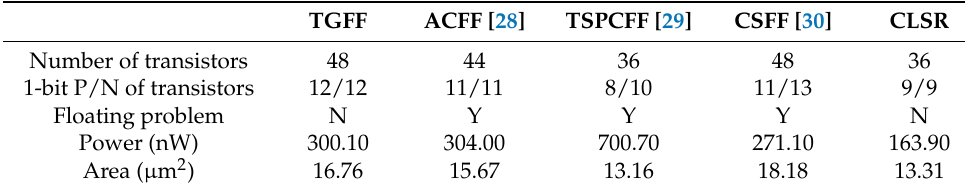
Figure 3. Snapshots of post-layout simulation waveforms. ACFF design: top rows. TSPCFF design: next rows. CSFF design: bottom rows. Table 1. Transistor-count comparison of 2-bit latch shift register.